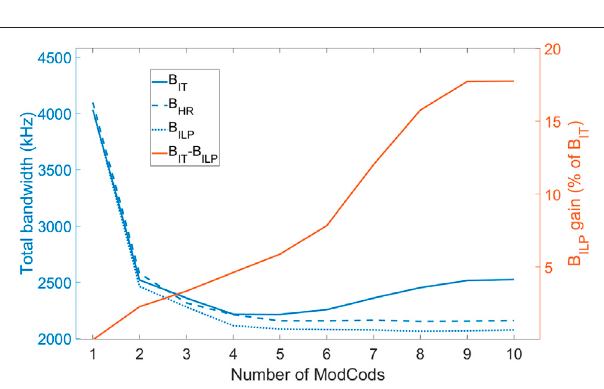
FIGURE 10 | Impact of the number of ModCods on the bandwidth ( T CIR (cid:1) 2 kbps, N (cid:1) 1,000).